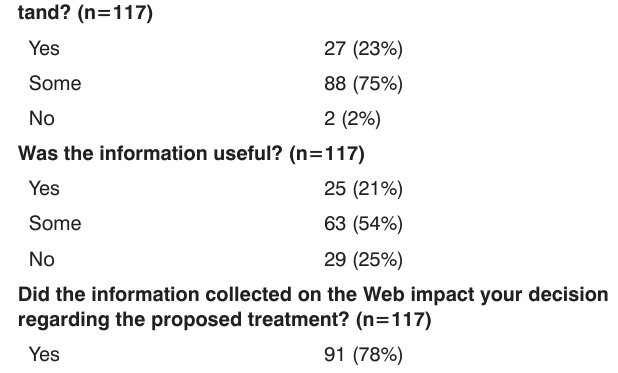
Table 3. Questionnaire - w searching for surgery information on the Web Was the information readily accessible and easy to unders- tand?